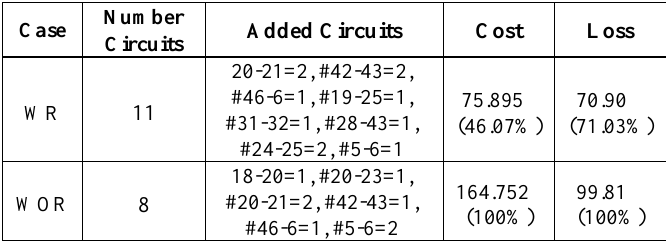
Table 6: SB-46/79 test system - Comparison of the